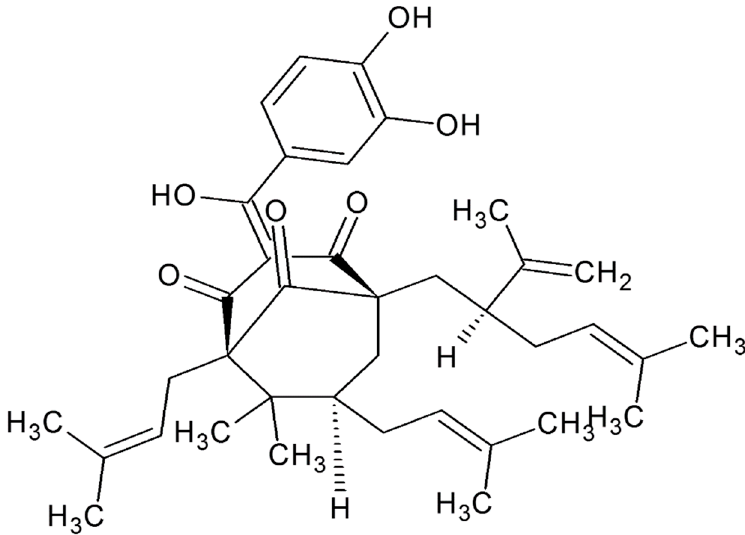
Figure 1. Chemical structure of garcinol.